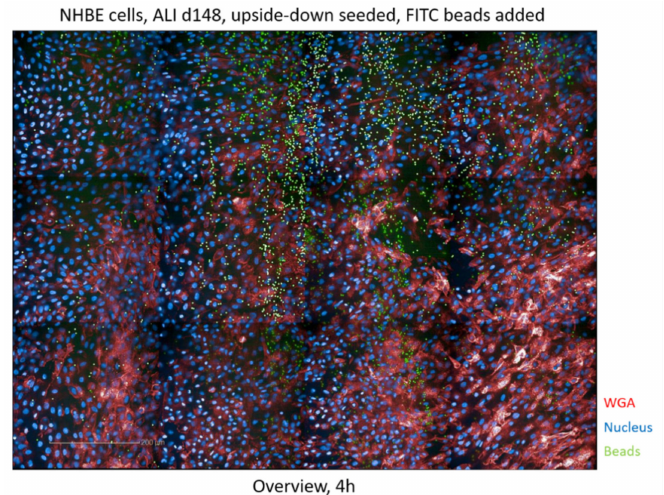
Figure 4. Analysis of mucociliary clearance of NHBE cells cultured in birch-based cellulose hydrogel and upside-down. High content screening of the mucociliary clearance was performed after the addition of fluorescently labeled beads (green) and an overview of the bead distribution is depicted. The experiment was repeated three times in independent